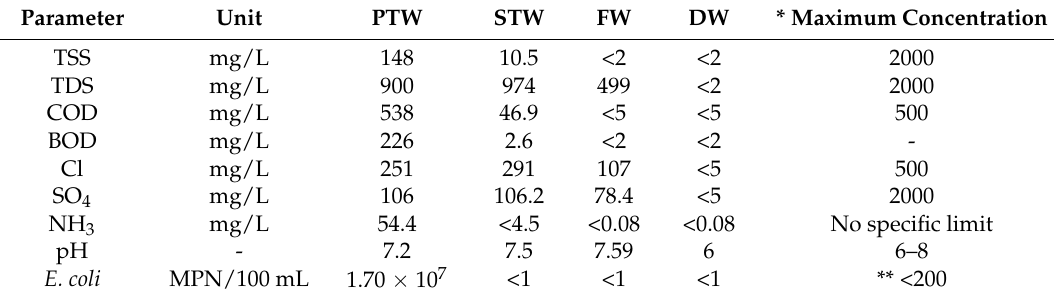
Table 4. Water quality analysis of Treated wastewater (Primary Treated Wastewater (PTW) and Secondary Treated Wastewater (STW)), Fresh water (FW), Distilled Water (DW) and the mixing water permissible limits for